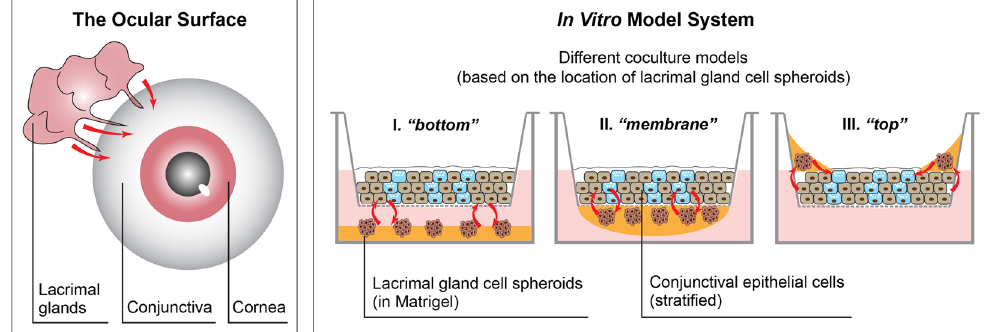
Figure 1. The ocular surface and in vitro model system, showing models with different cell organizations. The name of coculture models were based on the location of LG cell spheroids. Red arrows indicate direct or indirect interactions between different